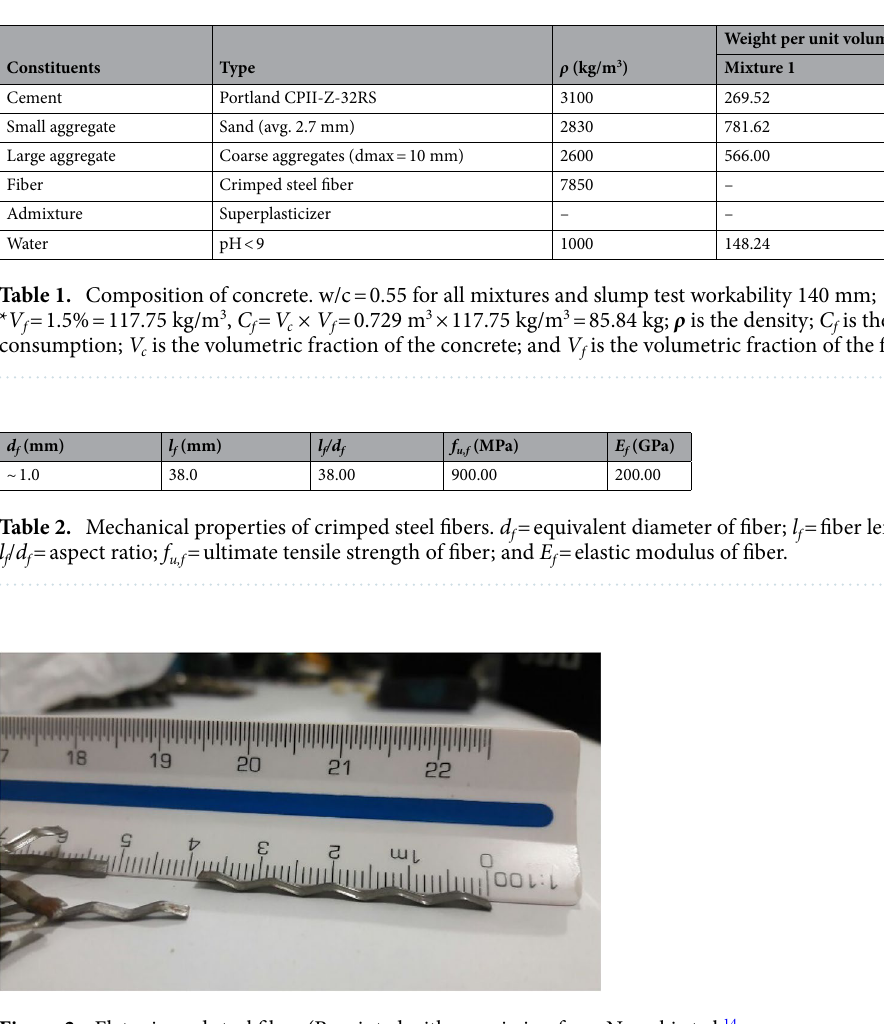
Figure 2. Flat crimped steel fiber. (Reprinted with permission from Nzambi et al. 14 .